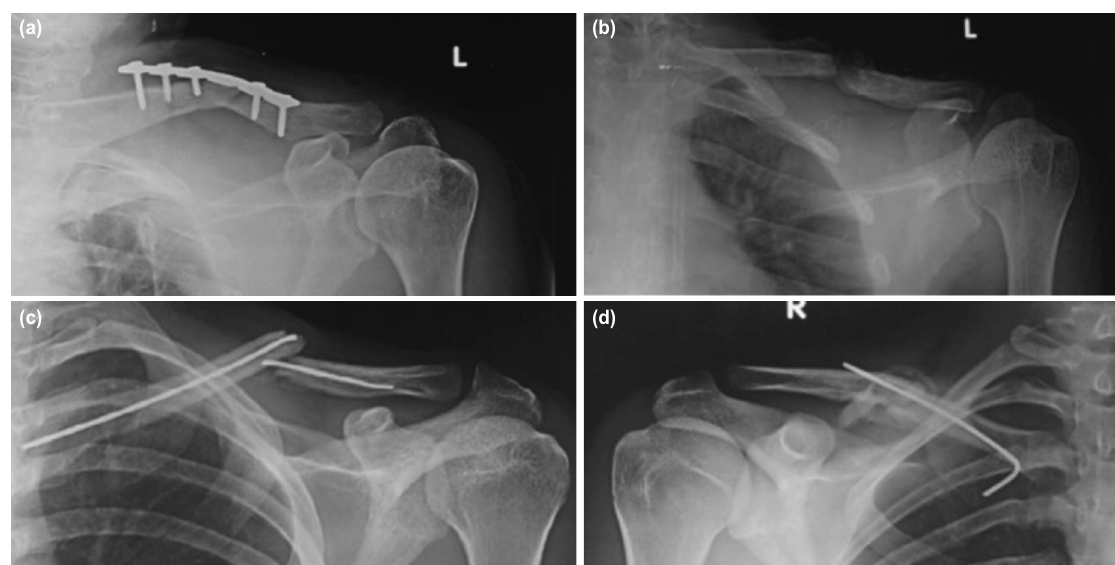
Complications following plating, (a) Implant loosening and backing out of screws, (b) Non-union of the fracture post implant Fig. 1: removal; complications following nailing, (c) Implant failure following re-fracture. (d) Implant failure due to piercing of the nail through comminuted fragments